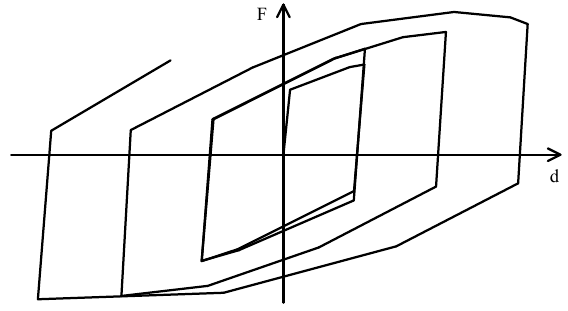
Figure 3. Material stress-strain relationship curve: ( a ) reinforcement, ( b ) concrete compression, and ( c ) concrete tension.